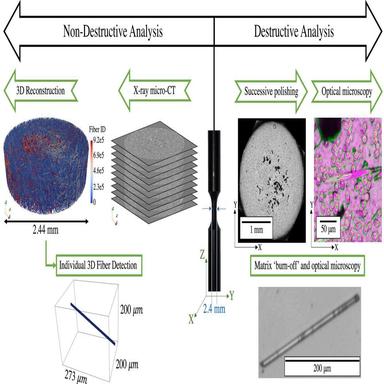
Comparing non-destructive X-ray μ-CT and typical destructive microscopy techniques for characterizing discontinuous fiber reinforced polymer matrix composites.